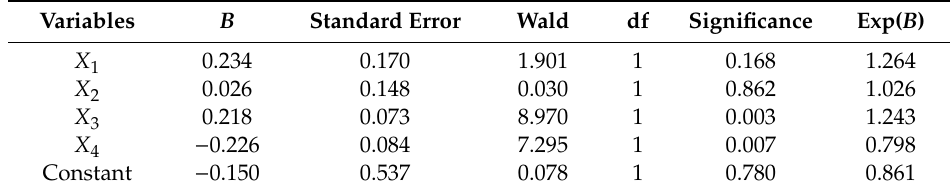
General classification accuracy Table 5. The variables in the model of the risk of low